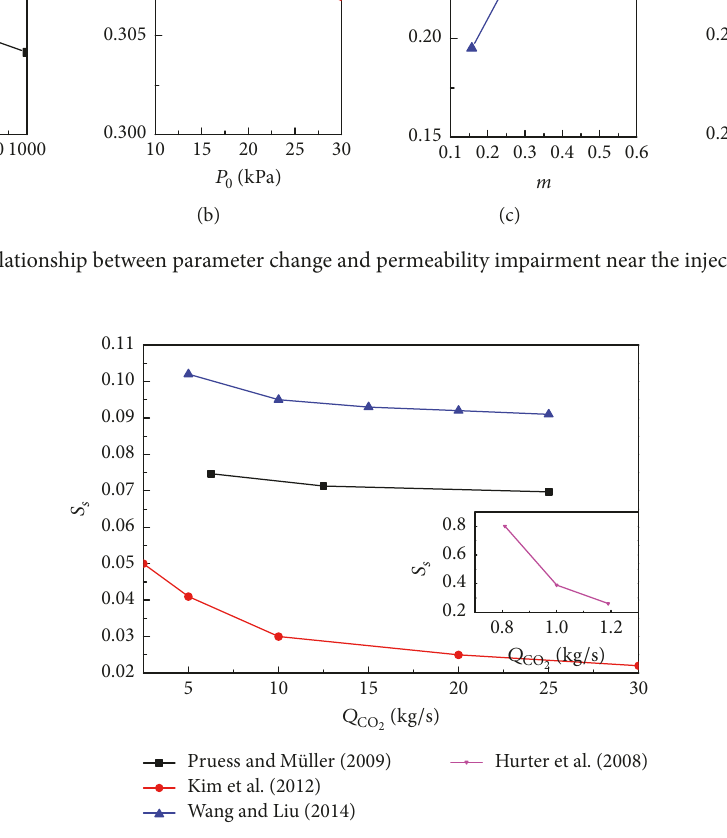
values are small). CO 2